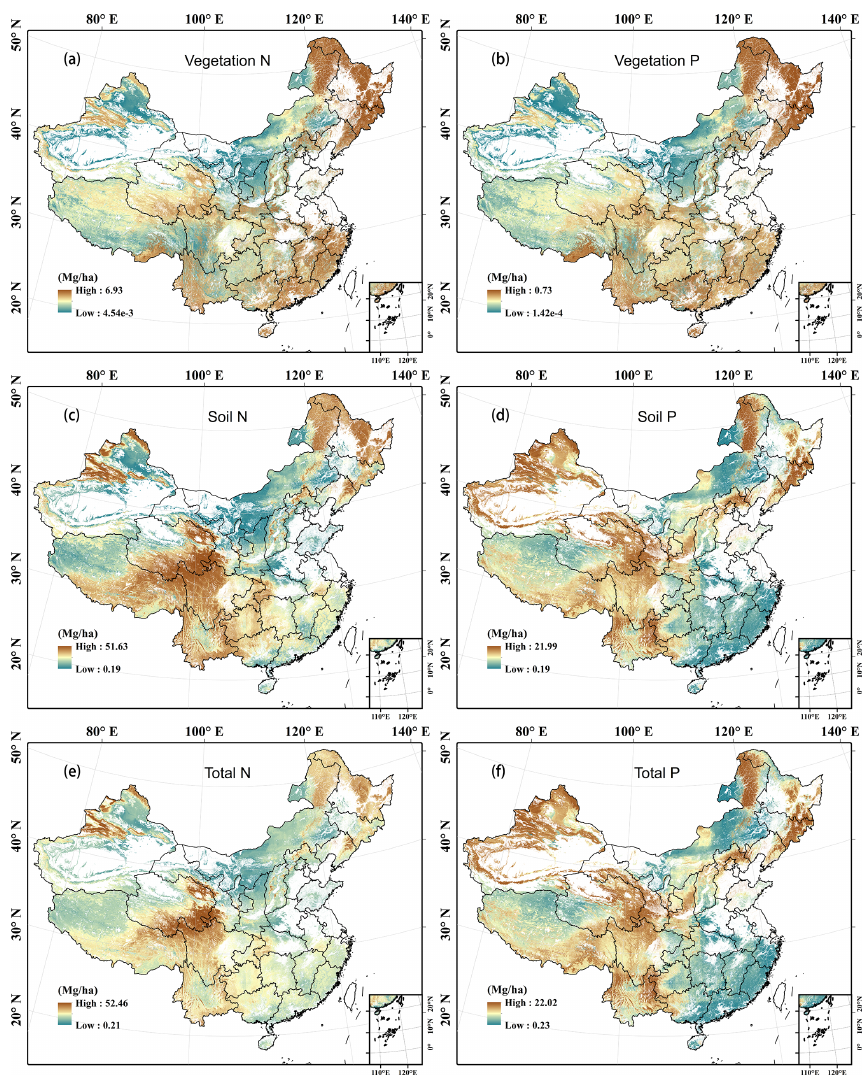
Figure 7. Predicted spatial patterns of N and P densities with a resolution of 1km in vegetation ( a, b : the sum of leaves, stems, and roots), soil ( c, d : the sum of five layers), and ecosystems ( e, f : the sum of vegetation, litter, and soil) of terrestrial ecosystems in